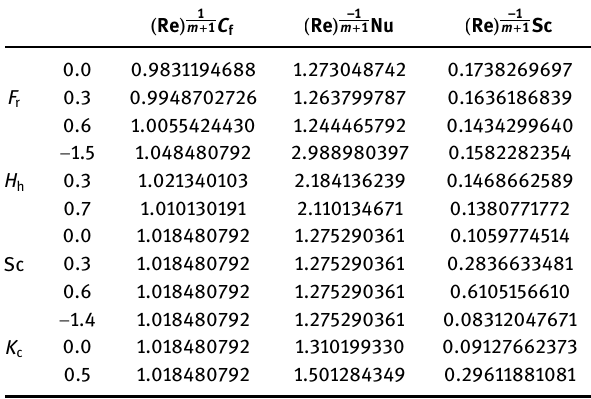
Table 4: Numerical simulations of skin friction coe ffi cient, concen - tration gradient and temperature gradient versus F H , , Sc